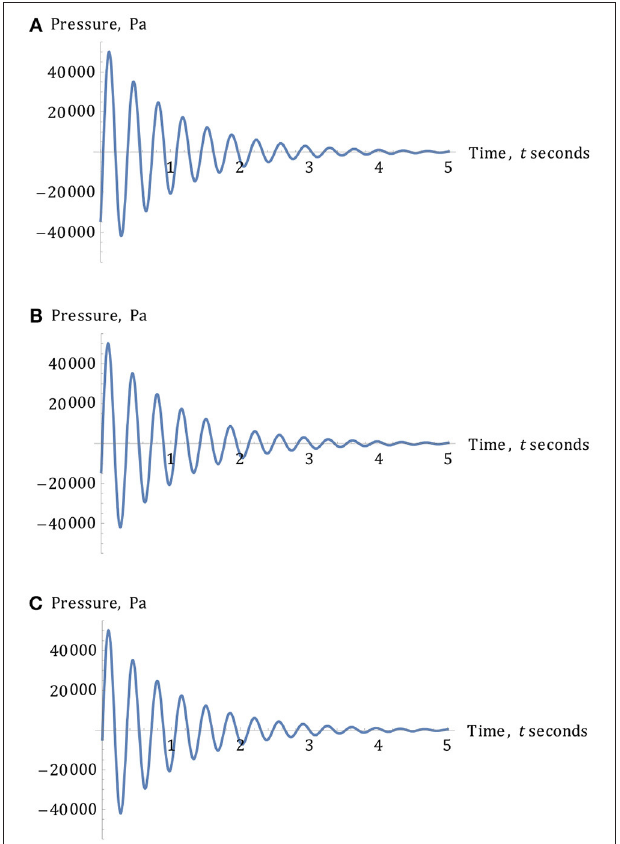
FIGURE 12 | (A) The variation of wave-pressure, P M a wave-velocity of 4 m/s over the time interval of 0 decreasing profile, complete with both under-pressures and over-pressures. (B) The variation of wave-pressure, P M wave-velocity of 10 m/s over the time interval of 0 decreasing profile, complete with both under-pressures and over-pressures. (C) The variation of wave-pressure, P M wave-velocity of 30 m/s over the time interval of 0 decreasing profile, complete with both under-pressures and